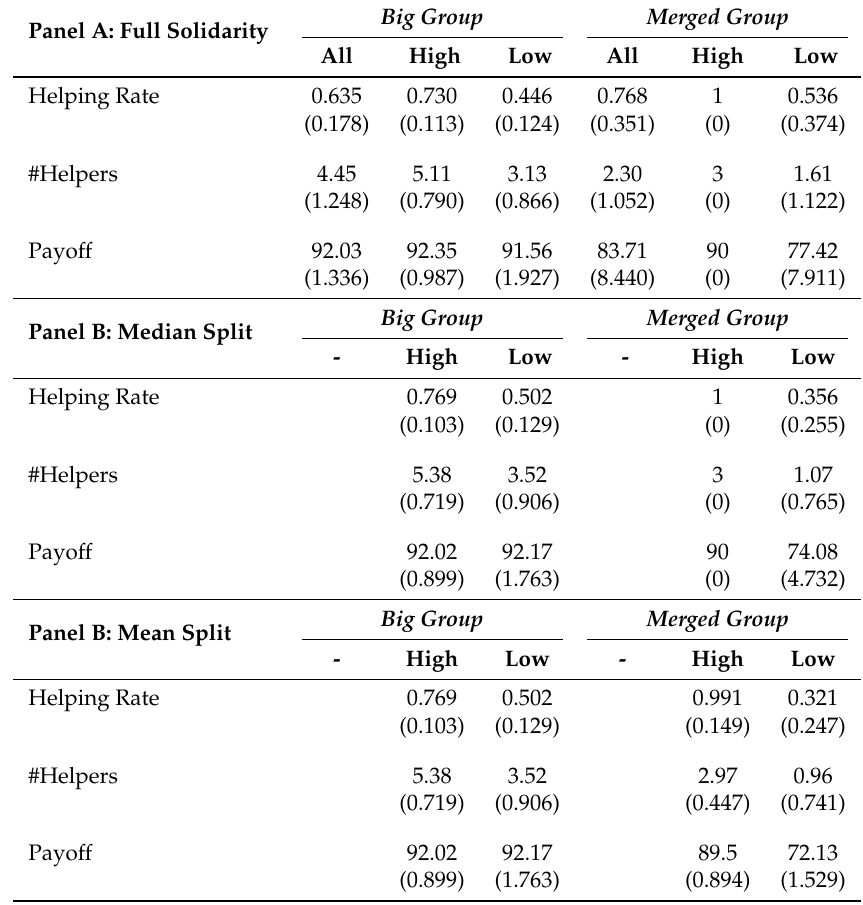
Table A14. Average helping rate, average group payoff and average helpers per group in Part A by treatment and